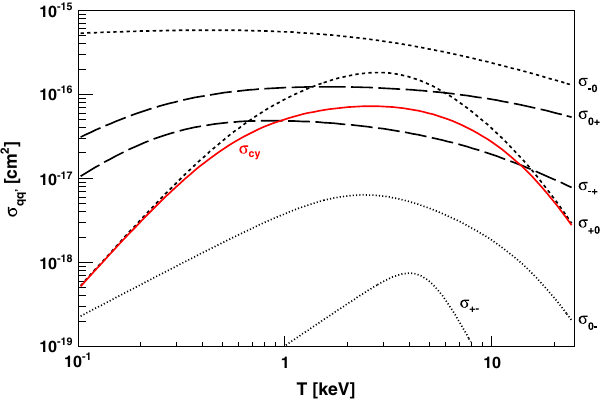
FIG. 2. Charge-exchange cross sections for (cid:1) þ in helium, velocity scaled from proton cross sections in [21] resulting in final states with (cid:1) ðþÞ (large dashes), (cid:1) ð 0 Þ (small dashes), and (cid:1) ð(cid:1)Þ (dots). The two-state charge-change-cycle cross section is shown in solid